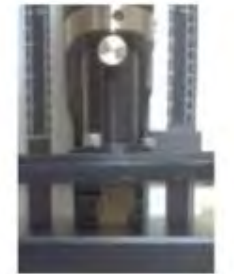
Figure 28. The Compression procedures in the testing machine (Author’s own,